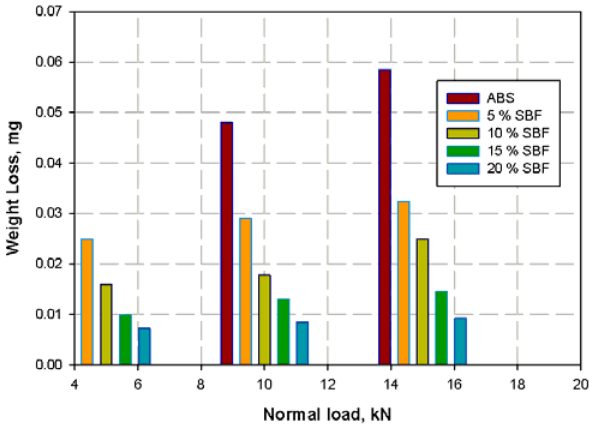
Figure 13. Wear resistance variation with normal load at a variation of wt % of SBF.